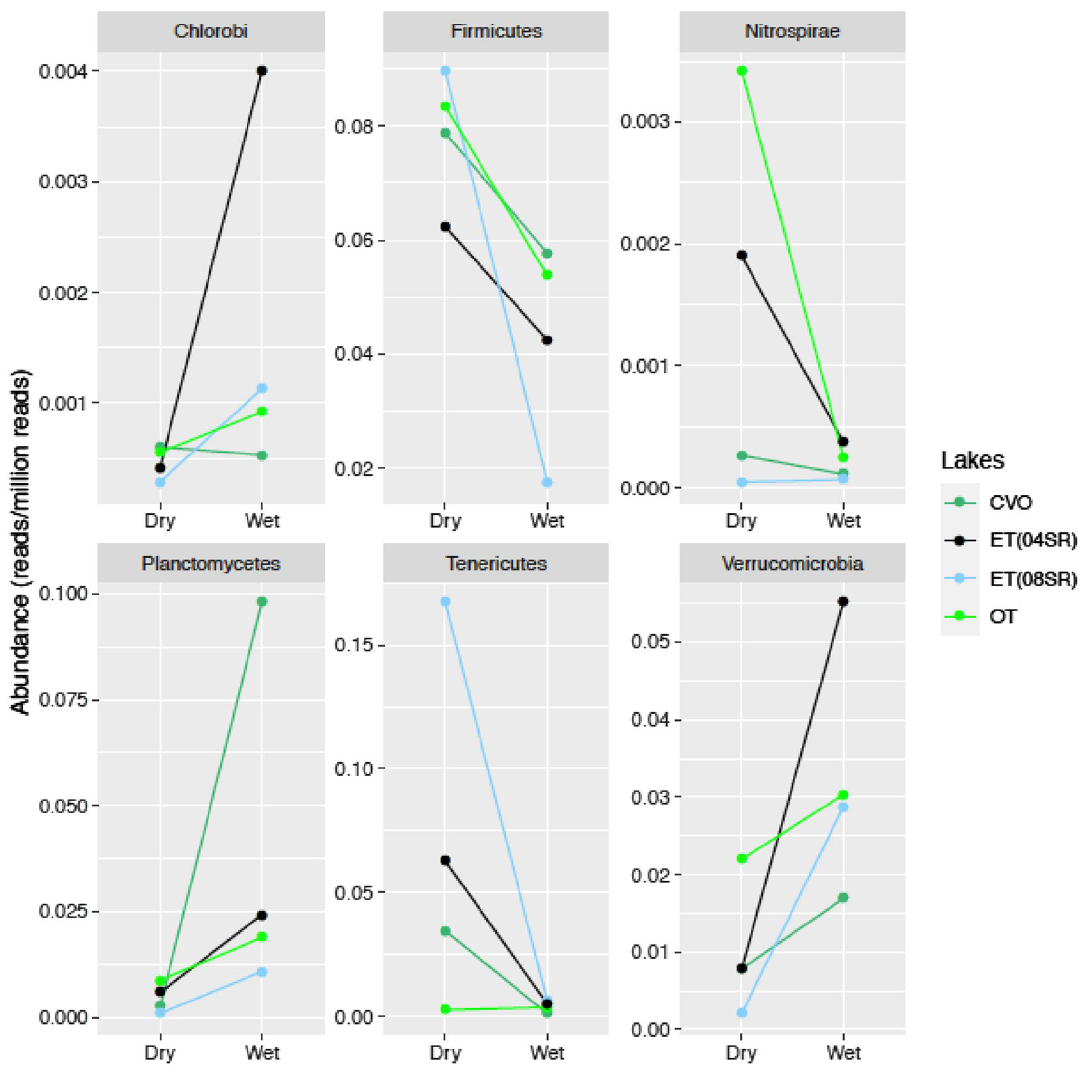
Figure 2. The differential abundances of bacterial groups associated with seasonality per lake. It was represented only in the groups whose abundance differed significantly between the harvest period ( p <